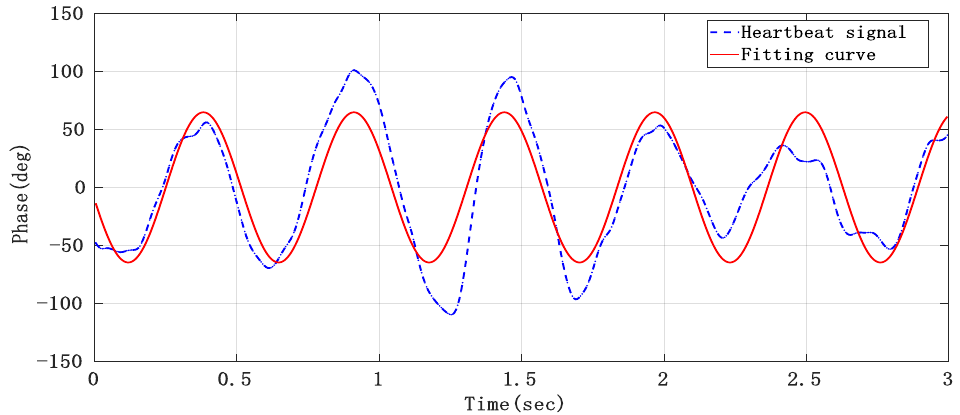
Figure 16. The heartbeat signal obtained after curve fitting.